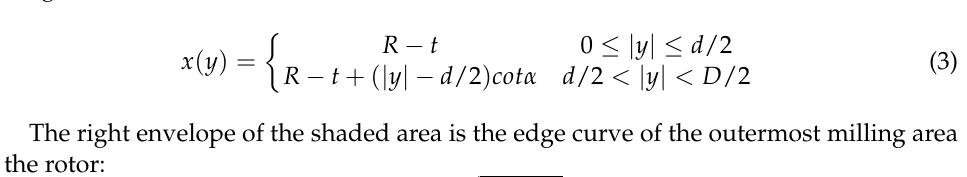
Figure 3. Analytical model of V-shaped milling: ( a ) milling section on the X–Z plane; ( b ) milling section on the X–Y plane.